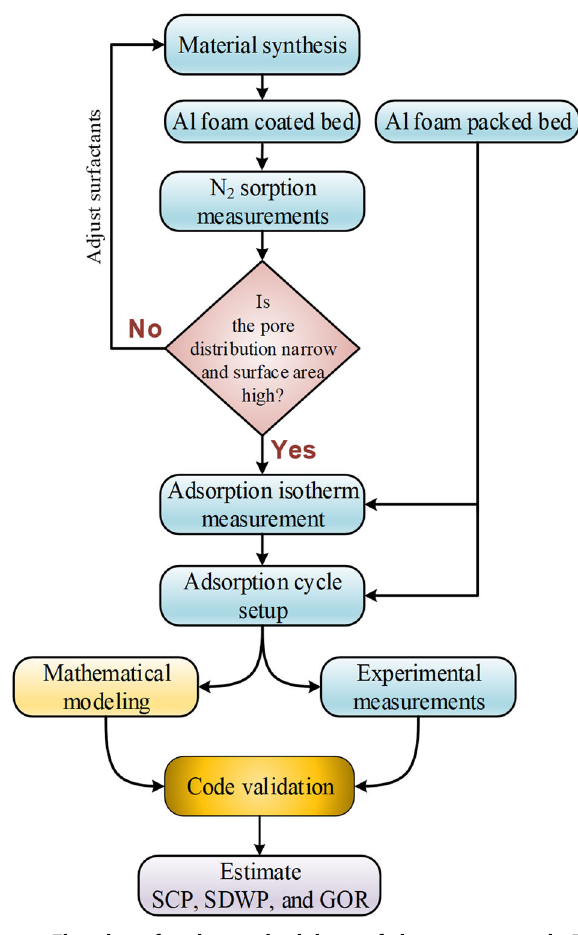
Fig. 9 Flowchart for the methodology of the present work. The surfactants used in the self-assembly process were adjusted to produce silica with desired microstructure characteristics for adsorption cooling and desalination